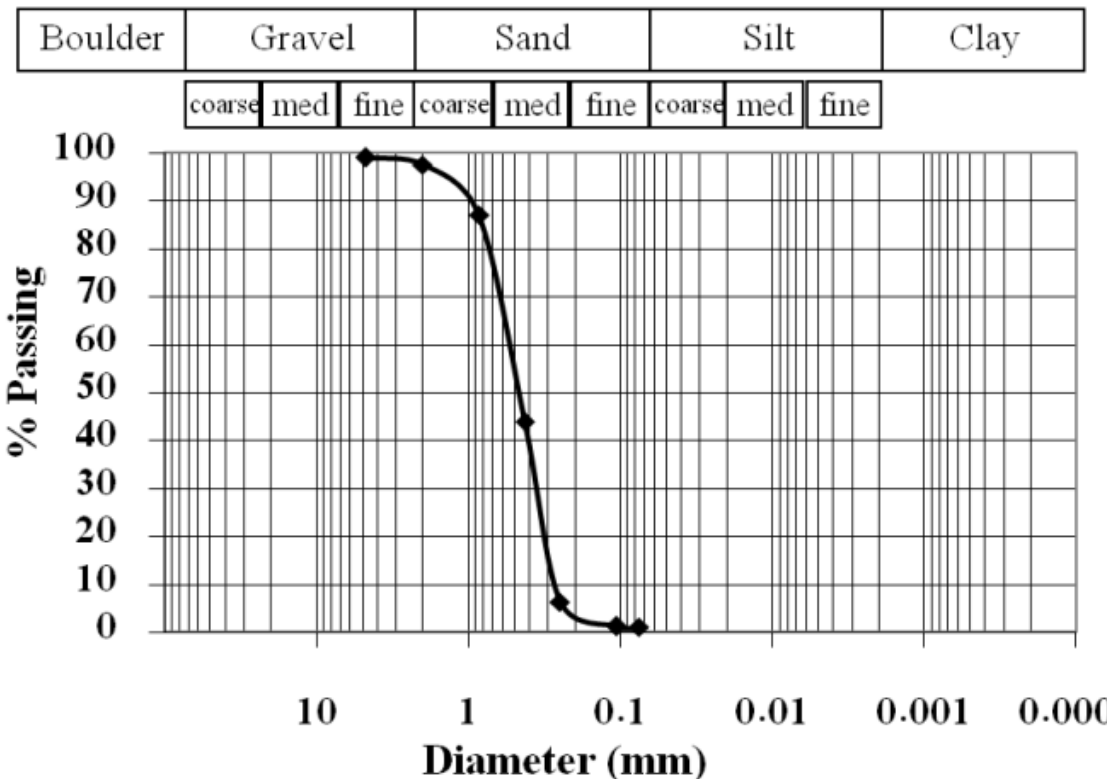
Figure 11. The sieve analysis of specimen 5 at 67.9E km at El-ferdan